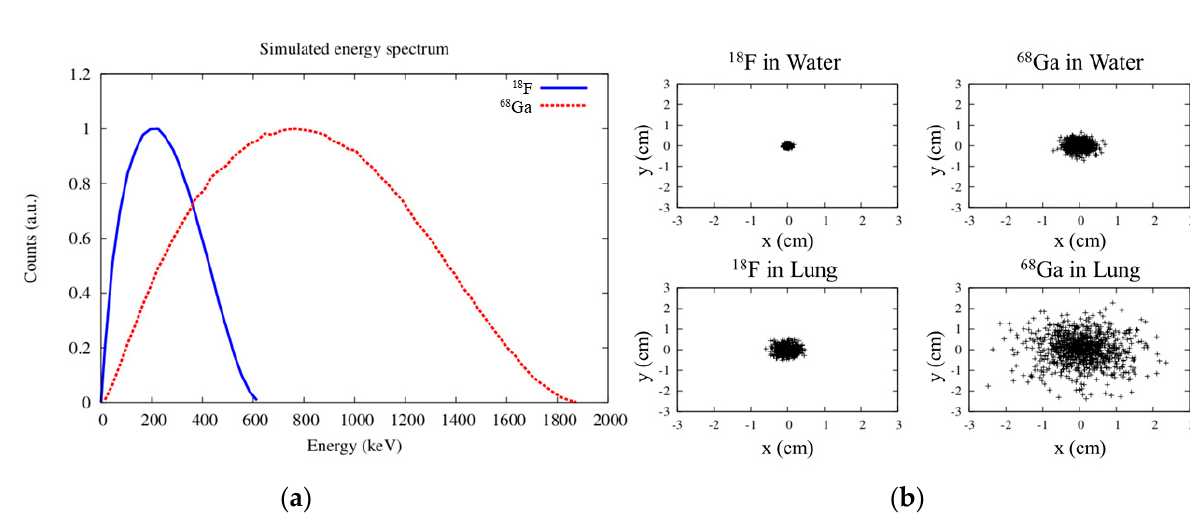
Figure 1. Simulated energy spectra of positrons emitted by 18 F and 68 Ga obtained with the code PenNuc [18] ( a ), and distribution of annihilation points for 18 F and 68 Ga in water and lung tissue ( b ).